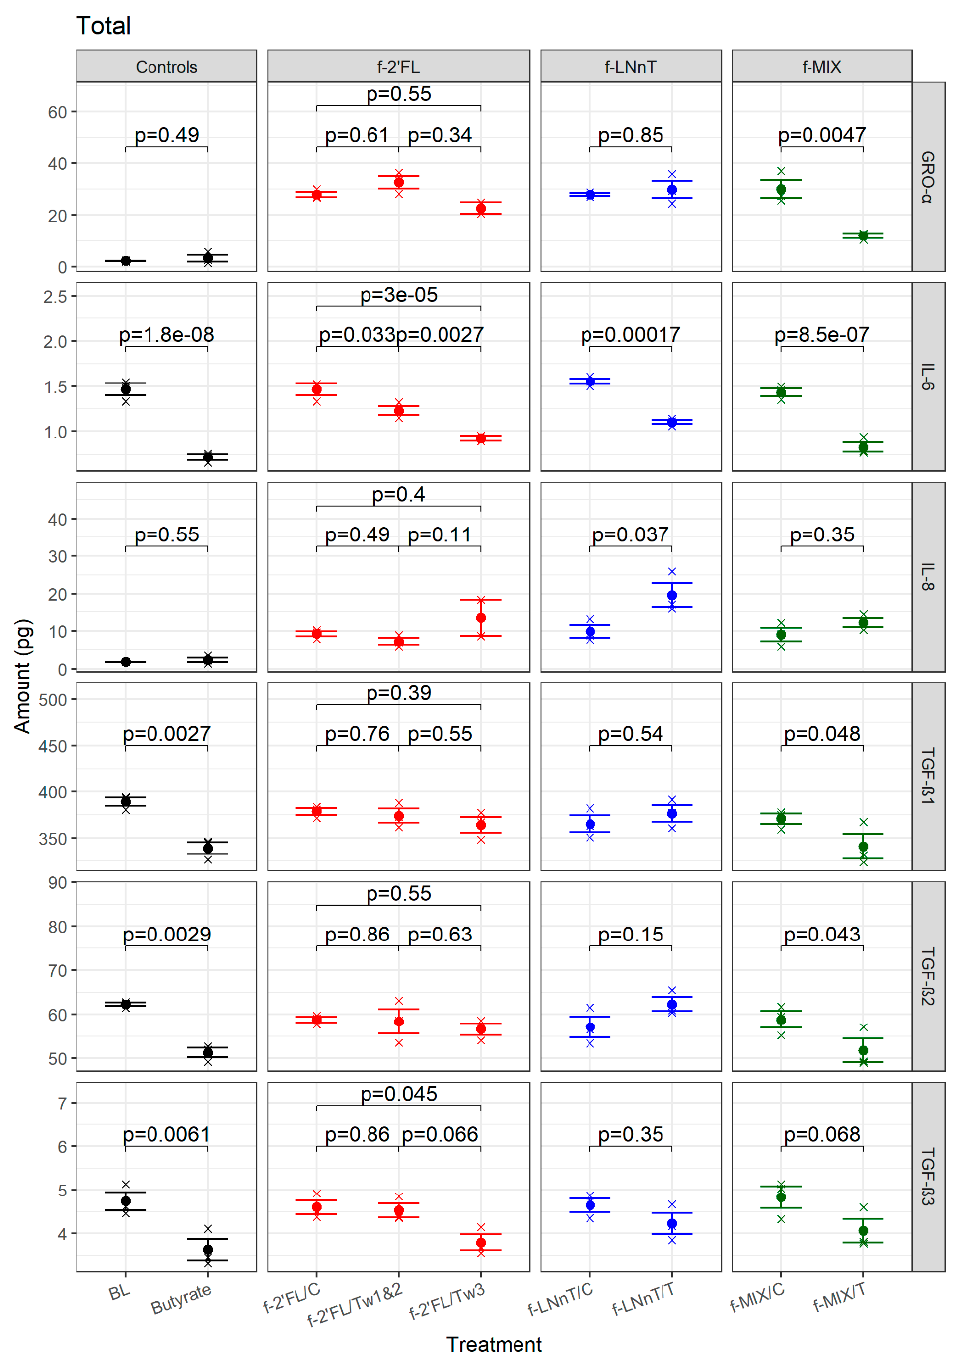
Figure 4. Impact of f-HMO treatment on cytokine secretion of Caco2 cells. Caco2 cells grown on transwells were treated with f-2’FL, f-LNnT, and f-MIX samples, for 24 h. Total amount of secreted cytokines GRO- α , IL-6, IL-8, and TGF- β 1–3 are shown (pg). Medium only treated cells (BL) and 5 mM butyrate-treated cells were included as controls. The p -values shown alongside each comparison are FDR-corrected (see Section 2 for details).